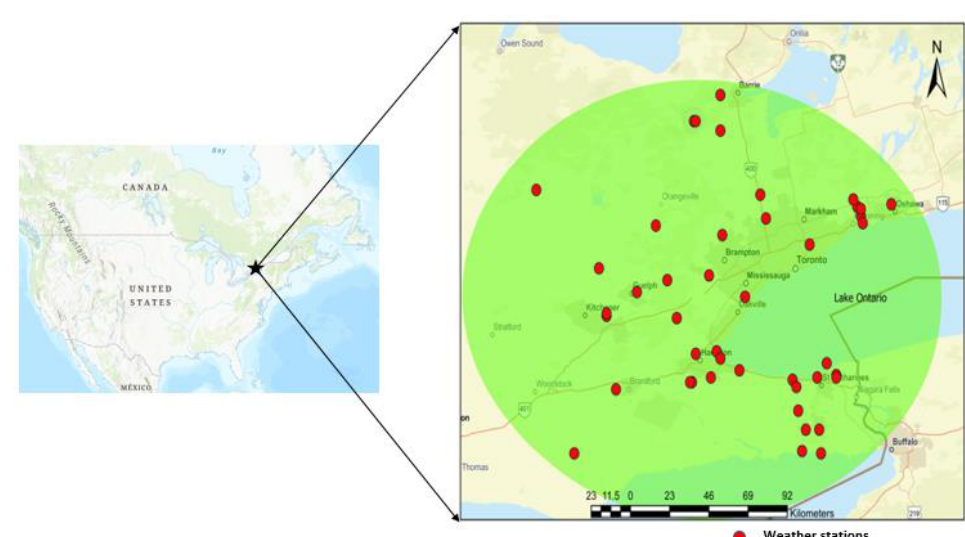
Figure 1. The locations of the study area and all the weather stations used in this study. The area in green represents the 100 km buffer around Milton, encompassing the populated Southern Ontario region. Milton is located at 79.9° W, 43.5° N.